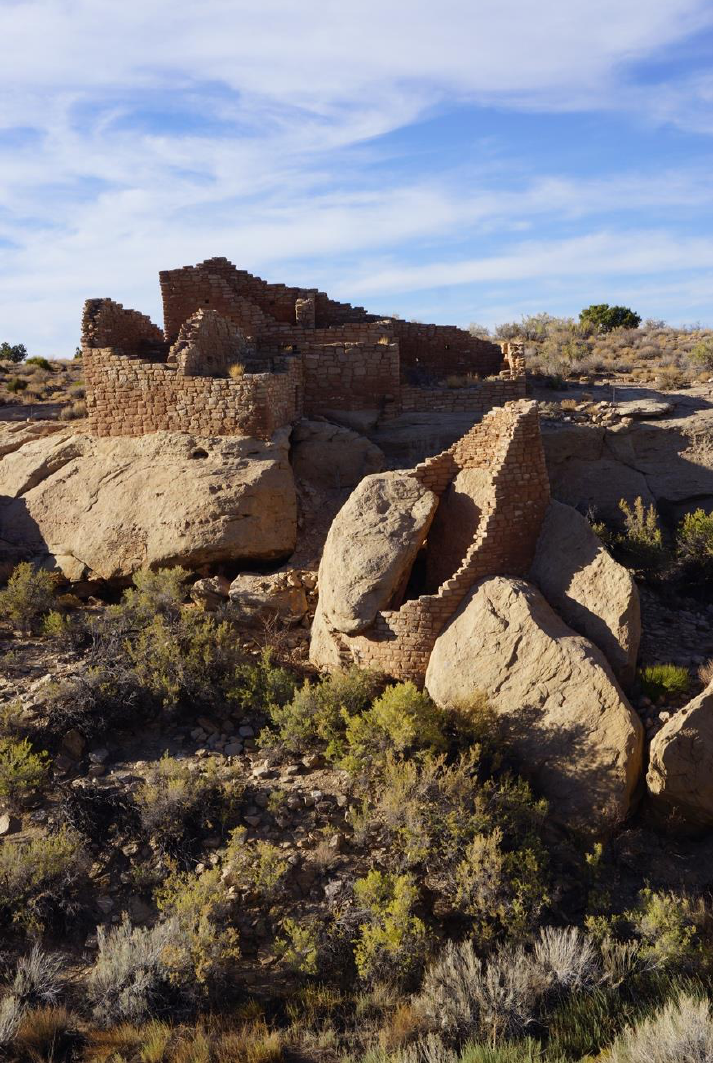
Figure 21. Round Towers Built Around Large Stones at a Canyon Head next to the Spring at Hovenweep.